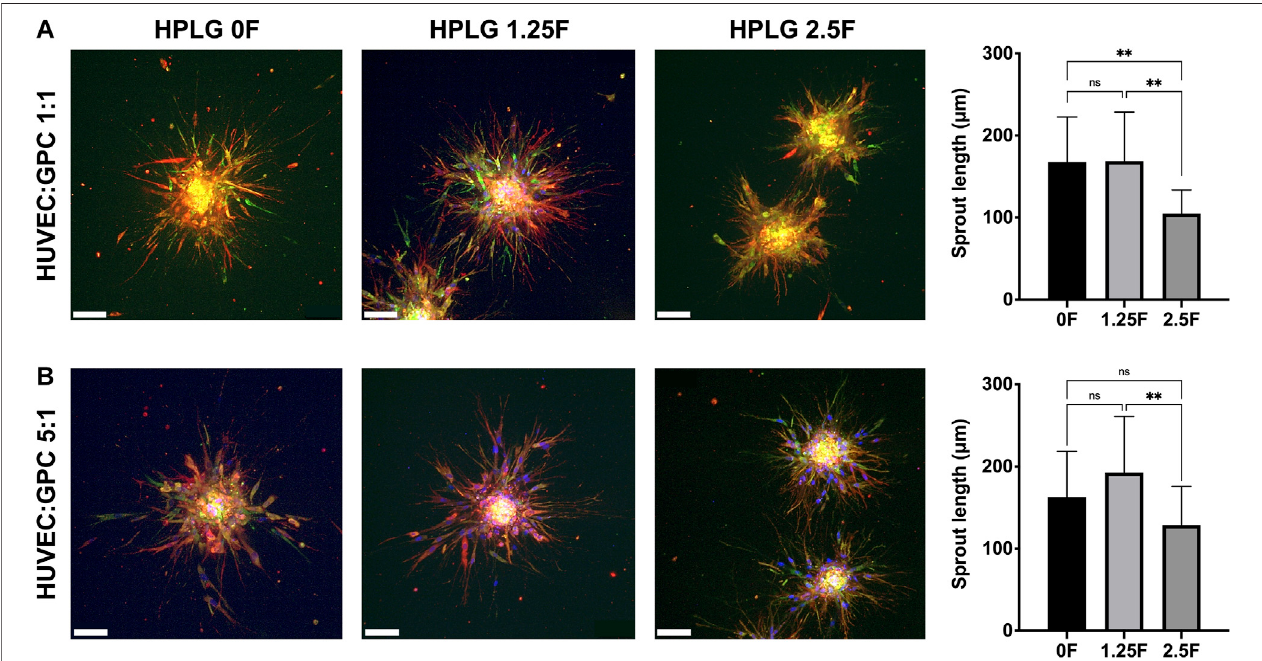
FIGURE5| Optimizationofcocultureratios.RepresentativeconfocalimagesofHUVEC-sprouting(red)andGPC-spreading(green)after72 hin1:1 (A) and5:1 (B) HUVEC:GPC coculture spheroids in 0, 1.25 and 2.5F HPLG (scale bars 100 μ m) and corresponding quanti fi cation of sprout lengths; ** p < 0.001; data represent means ± SD of at least three experimental repeats (n (cid:2) ≥ 5 spheroids per experiment).